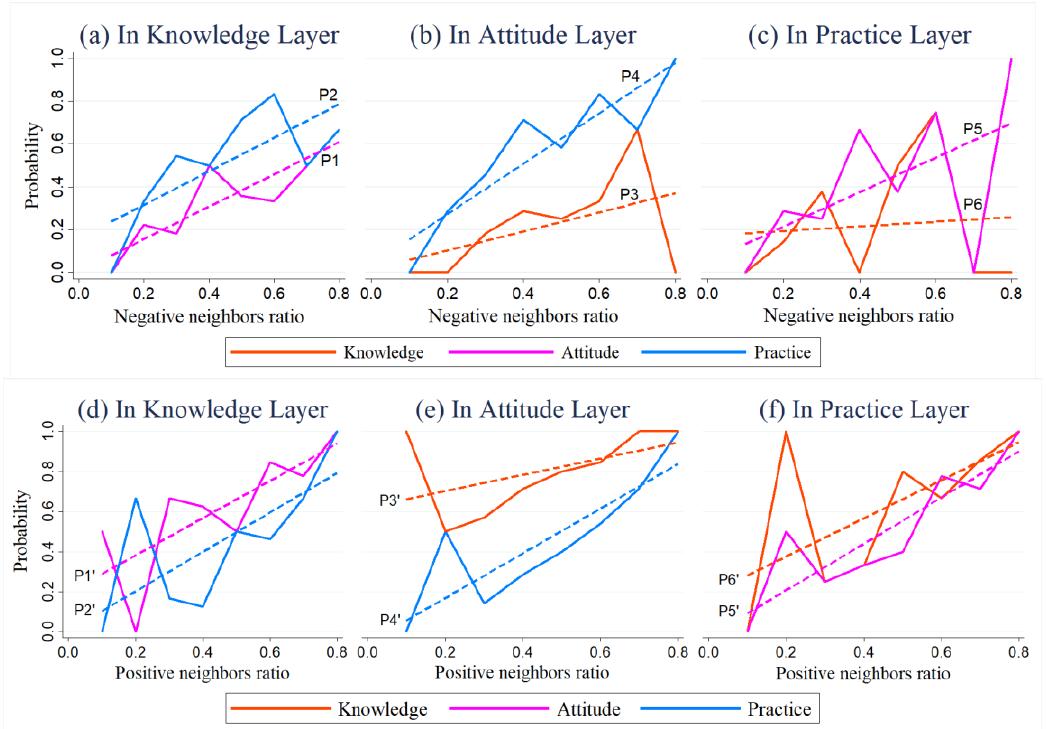
Figure 7. Negative ( a – c ) and positive ( d – f ) neighbors’ influence on positive FSWs. The solid and dashed lines represent the true values and the linear fitted values of possibility of q respectively. Please refer to Table A3 for the fitted equations and parameters of the models as well as the results of significant testing. We only provided the conclusions when the fitted lines passed the related significant